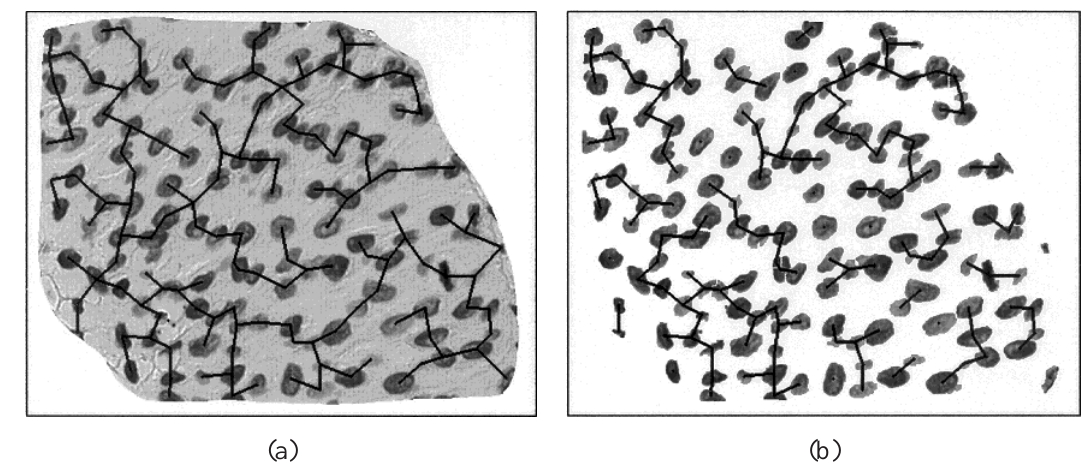
Fig. 4. (a) The minimum spanning tree of a tissue section with 153 vertices superimposed on the gray scale image. (b) The Euclidean distance between vertices has been thresholded at 16 µ m to create the 31